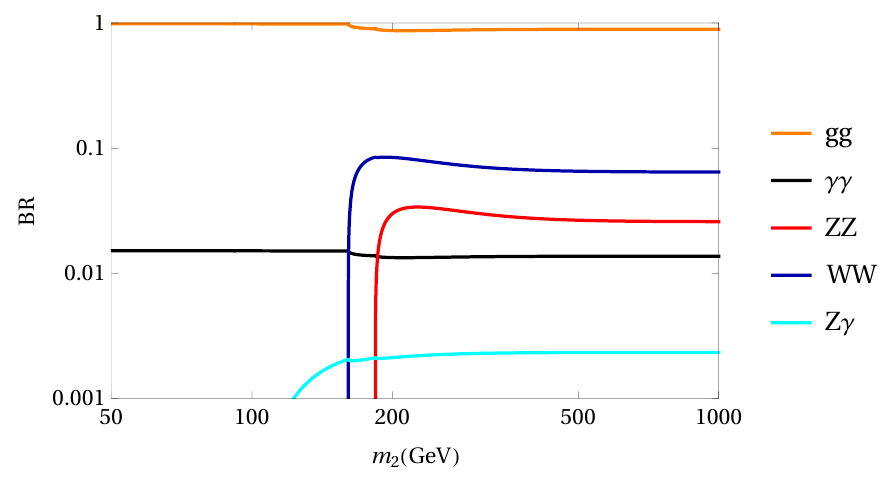
Figure 5 . The branching ratios of ψ 2 corresponding to different final states as functions of m 2 . The choice of parameters is Λ = 1 TeV and c B = g Y ( m Z ) , c W = g 2 ( m Z ) , c G = g s ( m Z )